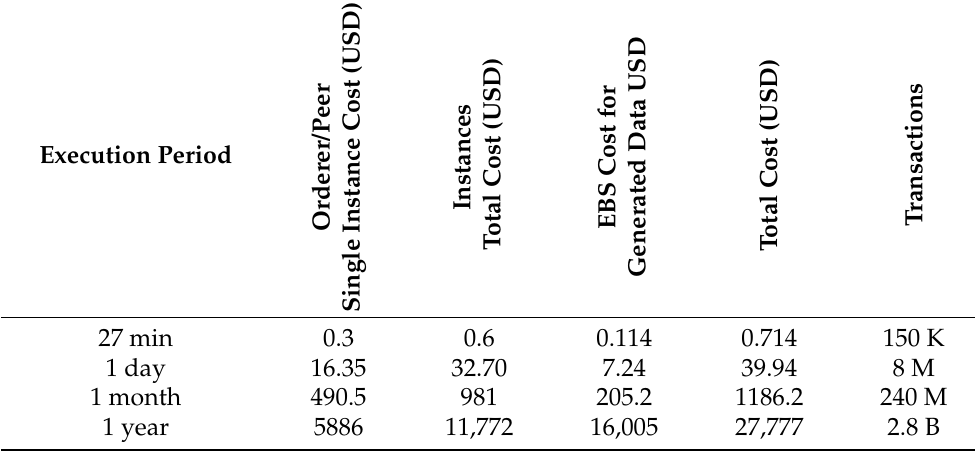
Table 10. Cost estimate based on round 4 of Phase 3 execution, but Phase 2 data generation and transaction